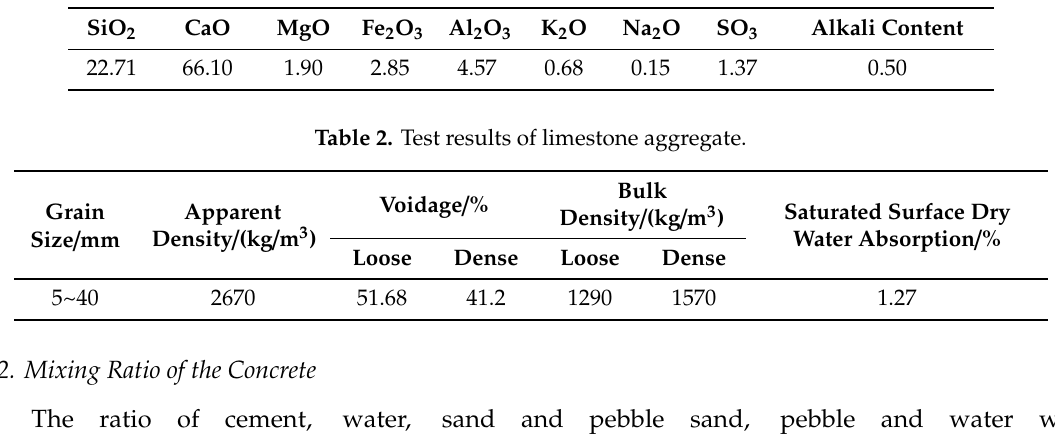
Table 1. Chemical composition of cement / %.